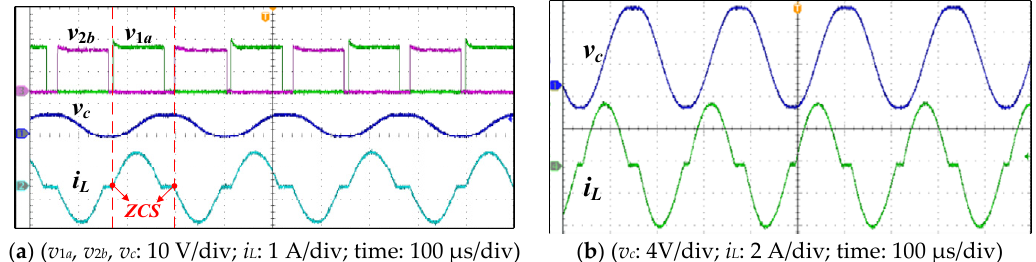
Figure 9. Experimental waveforms: ( a ) normal balance mode; ( b ) enhanced balance mode.